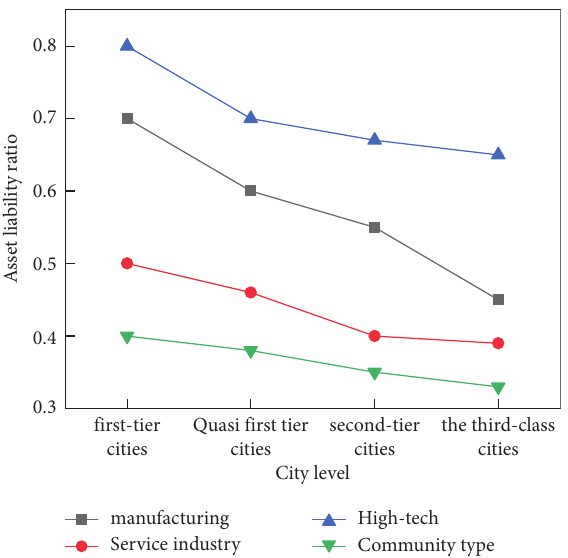
Figure 5: Asset liability ratio of various industries in different cities. Figure 6: Debt service ratio of various industries in different